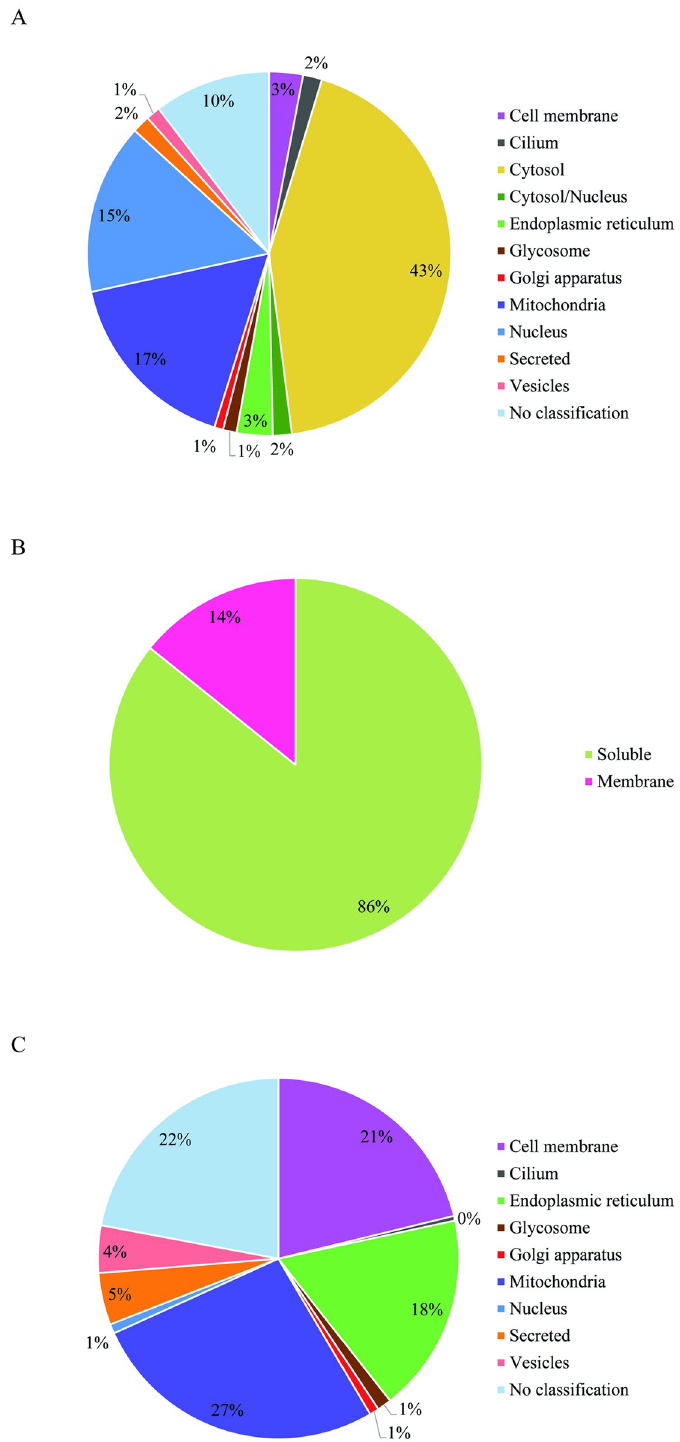
Fig 4. Classification according to subcellular localization of all proteins identified in the membrane-enriched proteome of PH8 and LV79 promastigotes. A. Circle chart showing percentage of proteins identified in proteomic analysis belonging to each subcellular localization. B. Circle chart showing percentage soluble and integral membrane proteins C. Circle chart showing percentage of integral membrane proteins identified in proteomic analysis belonging to each subcellular